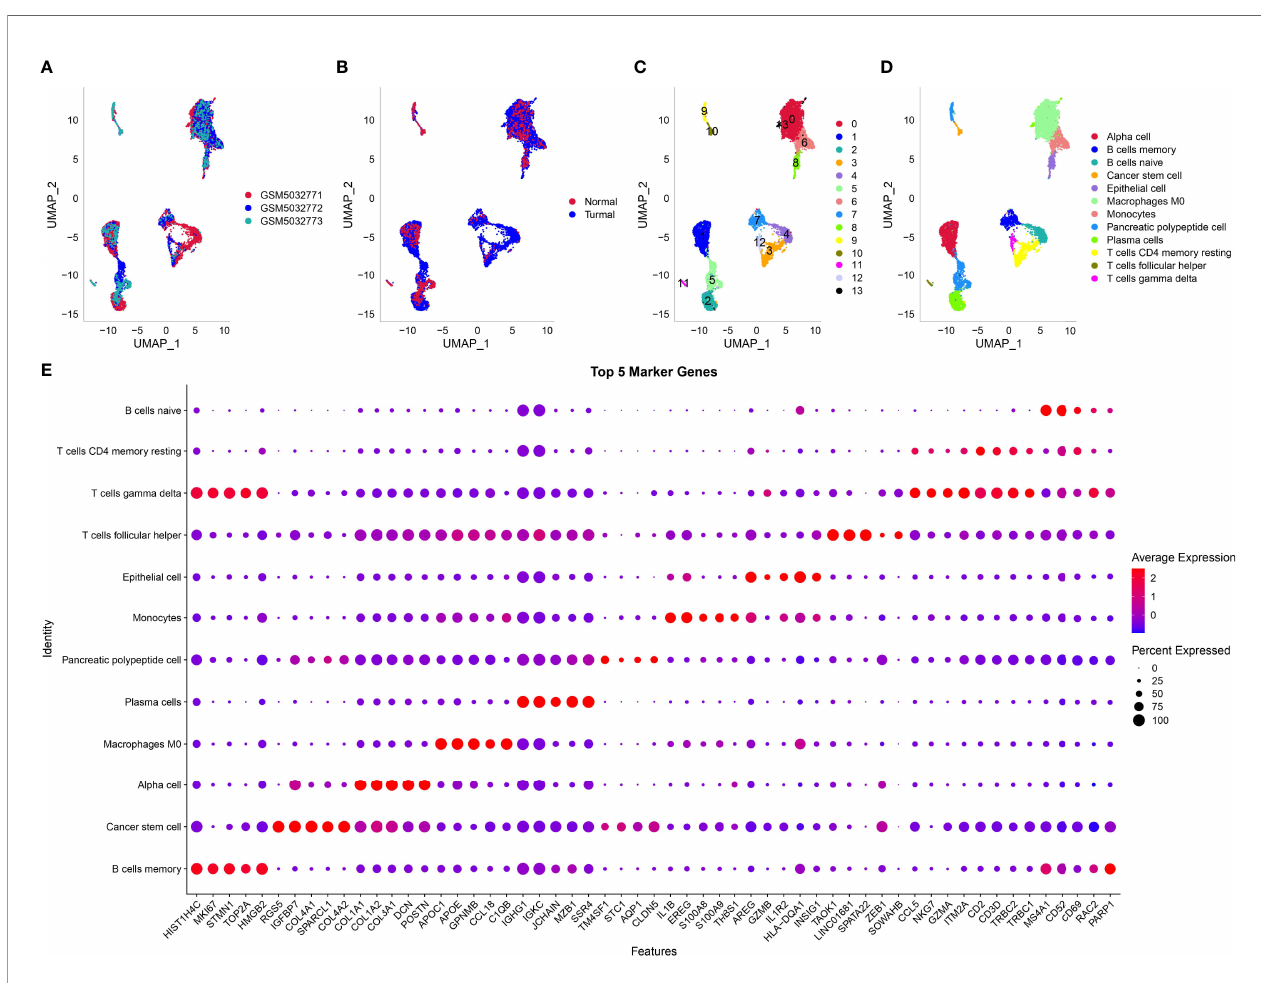
FIGURE 1 | Dimensionality reduction and subgrouping of single cells. (A) UMAP plot of three samples including GSM5032771, GSM5032772, and GSM5032773. (B) UMAP plot of normal and tumoral samples. (C) UMAP plot of cell subgrouping. (D) UMAP plot of cell type de fi nition. (E) The top fi ve enriched markers of 12 cell types. Horizontal axis indicated markers and vertical axis indicated cell